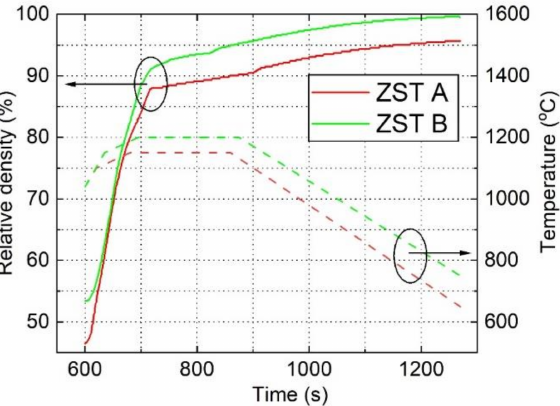
Figure 1. Relative density during SPS processing and the designed heating temperature versus SPS processing time for the samples ZST A (green lines) and ZST B (red